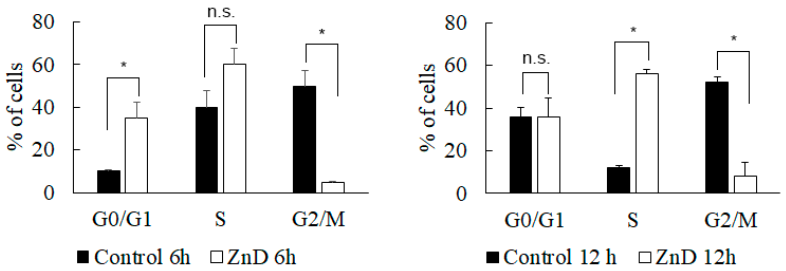
Figure 3. Cell cycle evaluation. Percentage of HCT116 cells in the different phases of the cell cycle after incubation for 6 and 12 h in the presence (0.217 µ M, IC 50 at 48 h) or absence (water) of the ZnD compound. PI fluorescent levels were determined by flow cytometry. The results are expressed as the mean ± SEM percentage from three independent experiments. * p < 0.05 compared to control. n.s.—no statistical difference.